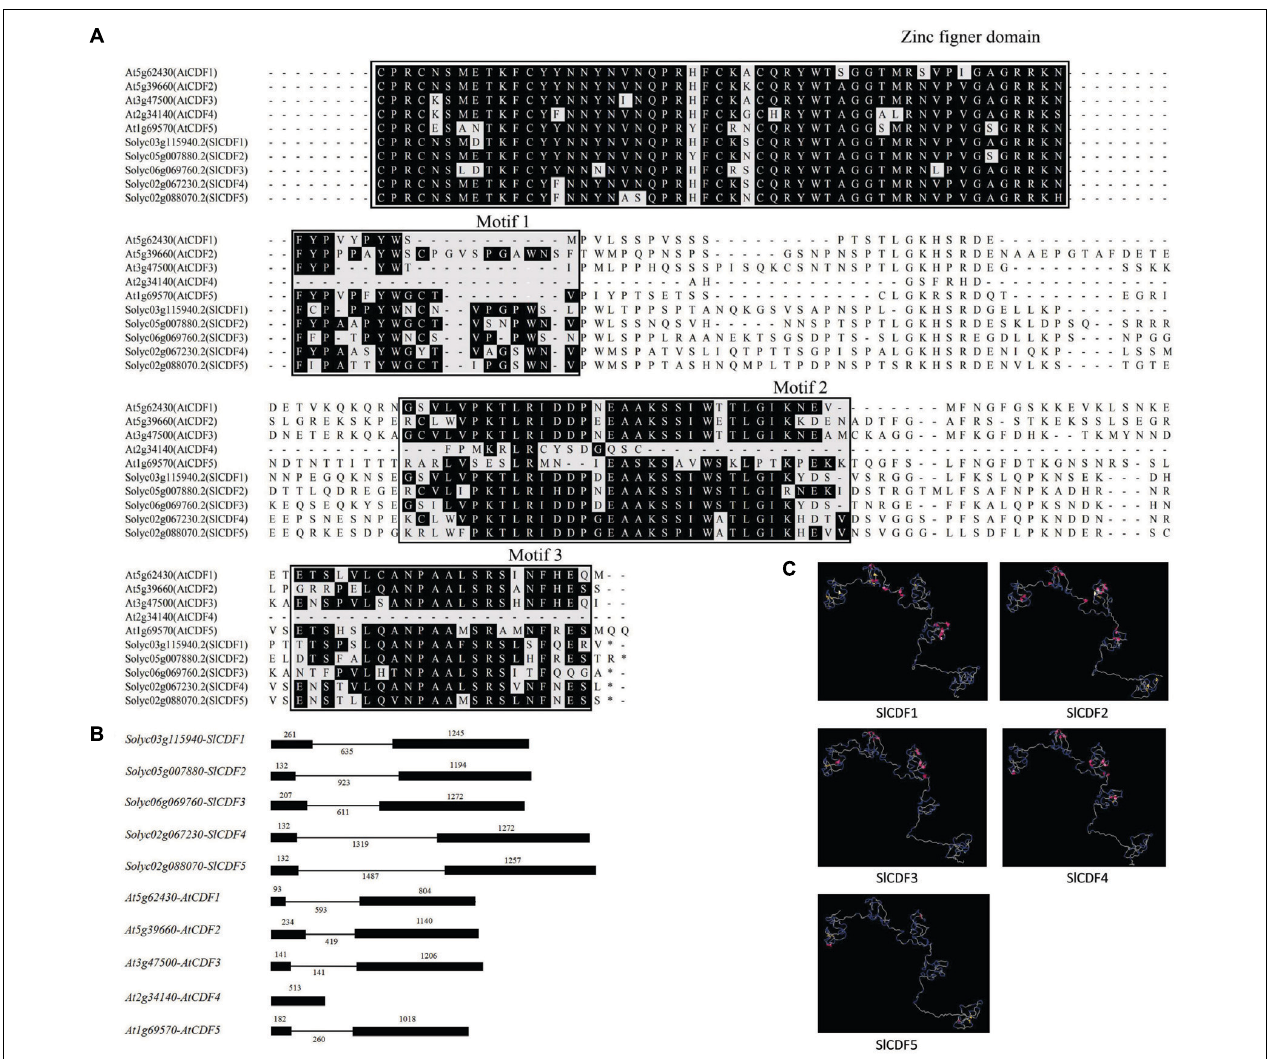
FIGURE 1 | The corresponding amino acid sequences and spatial structures of tomato SlCDF1–5 genes were highly conserved. (A) Amino acid sequence alignment of Arabidopsis and tomato CDF proteins. The sequences in the black box were highly conserved. (B) Exon-intron structure analysis of CDF genes. The black solid boxes represent exons, while the horizontal lines represent introns. (C) The simulated three-dimensional structure of tomato SlCDF1–5. The pink and yellow areas represent α -helices and β -sheets,